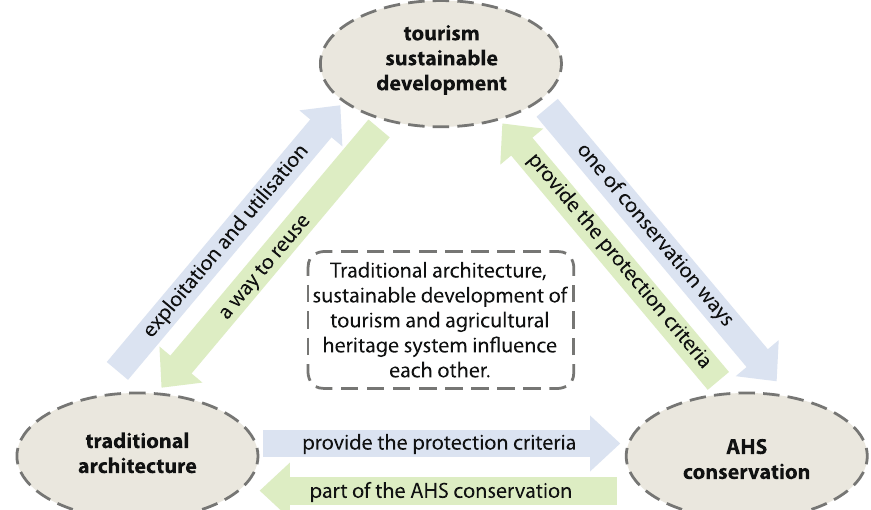
Fig. 2 Relationship among traditional architecture, sustainable tourism development and agricultural heritage conservation (Source: the